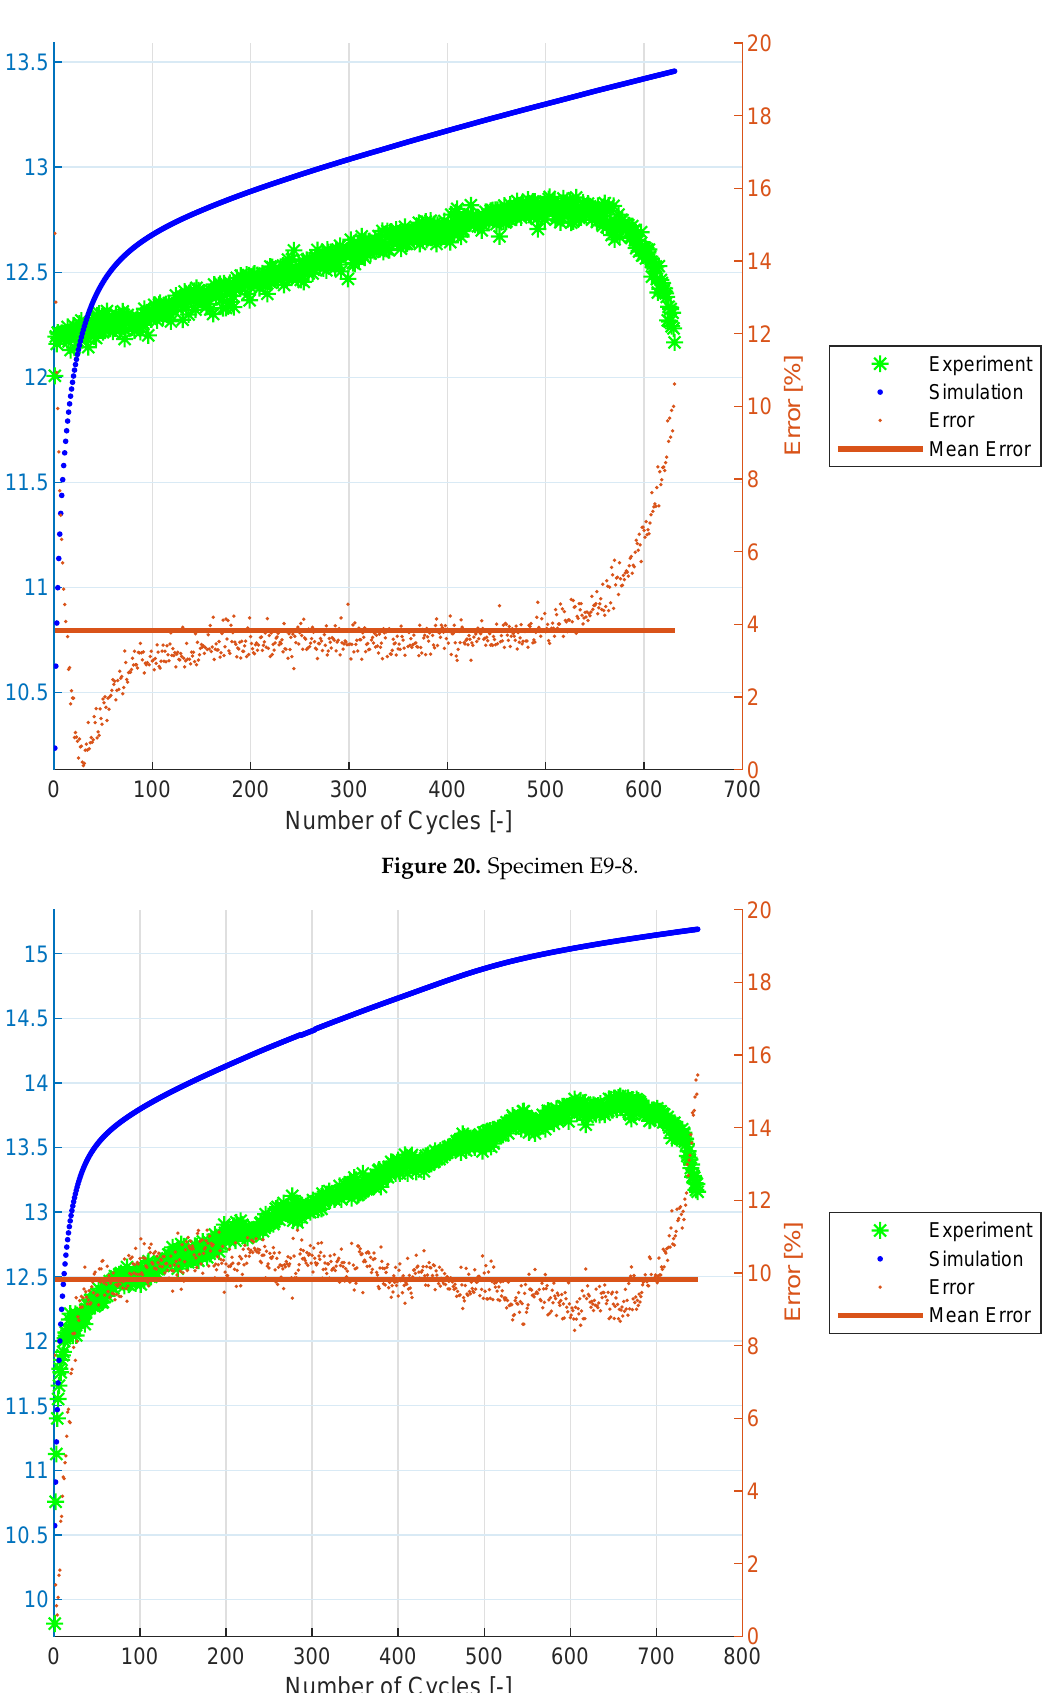
Figure 20. Specimen E9-8.